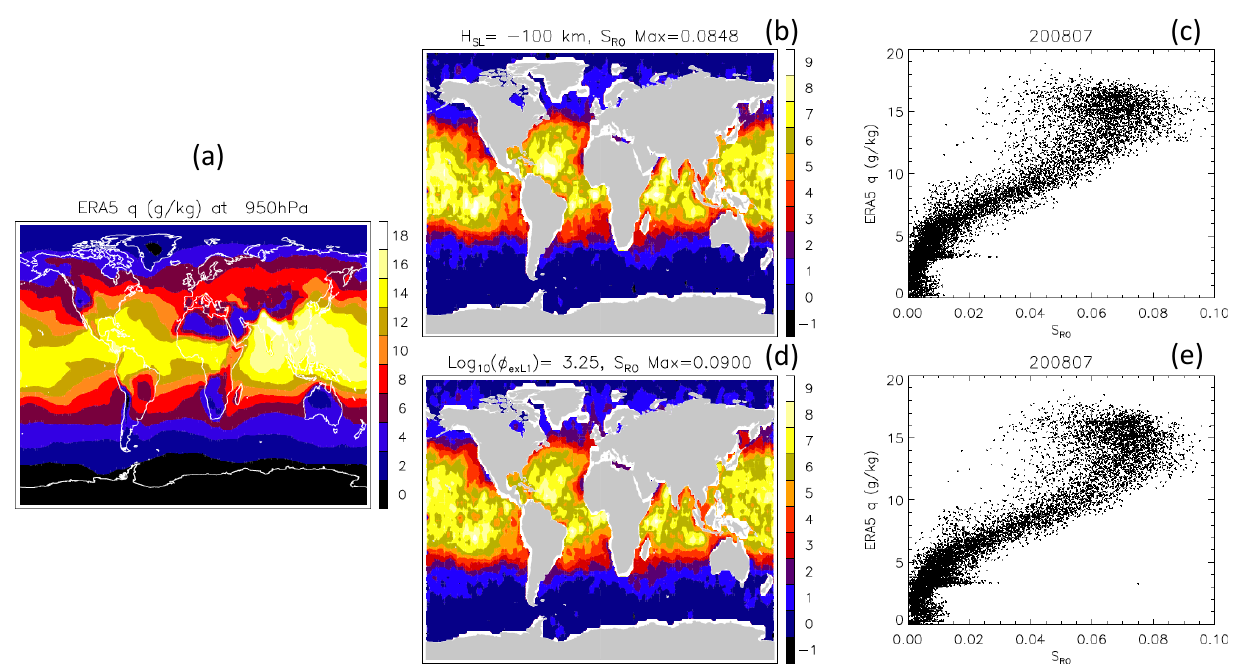
Figure 10. As in Figure 9 but for July 2008.